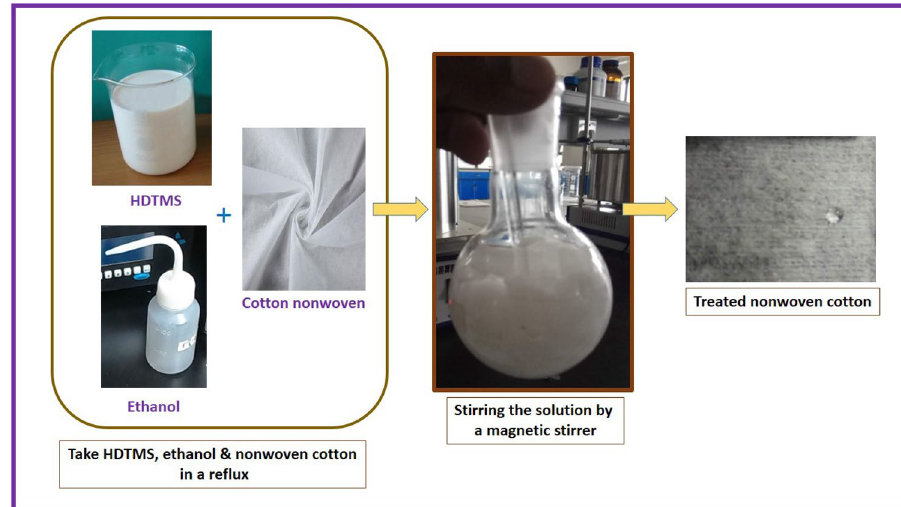
Fig. 2 Chemical application process for preparation of hydrophobic surfaces on cot- ton nonwoven